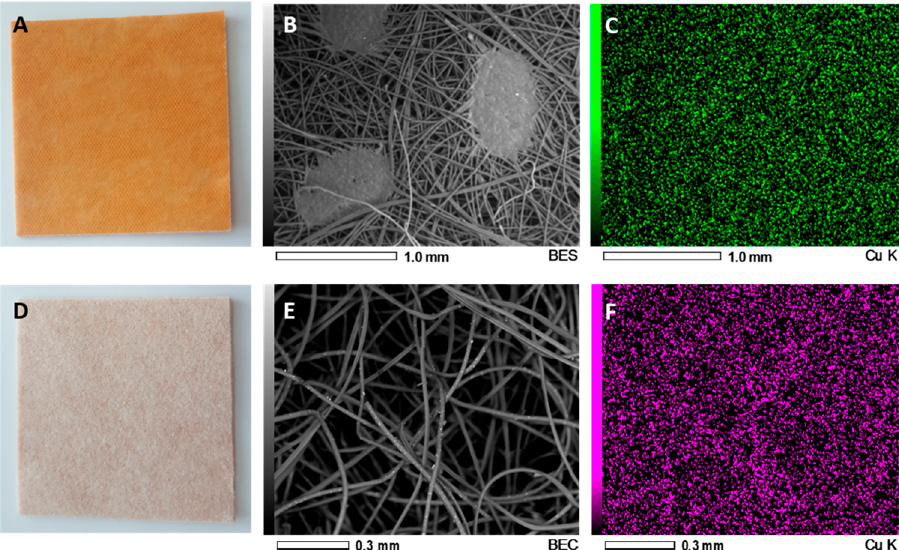
Figure 1. Scanning electron microscopy (SEM) of the copper oxide-containing wound dressing. The copper oxide wound dressing consists of two layers. A non-stick spunbond polypropylene layer ( A ) and a highly absorbent needle punch fabric ( D ). The non-stick polypropylene layer is put directly on the wound. Scanning electronic microscope (SEM) images ( B , E ) and energy-dispersive X-ray spectroscopy (EDS) analysis of each layer ( C , F ) demonstrate the presence of copper oxide microparticles impregnated in the fibers.